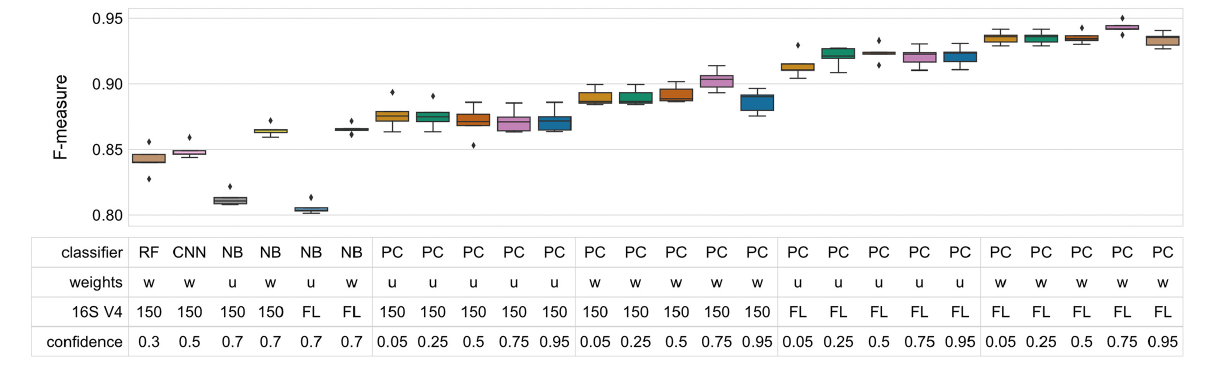
FIGURE 3 | “Perfect” classifiers demonstrate the upper bound of classifier performance for V4 and full 16S rRNA gene sequences. These classifiers only fail when two species share an identical sequence, assuming uniform weights. Taxonomic weighting slightly increases classification accuracy both for V4 and full-length sequences. Box-and-whisker plots indicate the median and quartile distributions of F-measures for each classifier, across 5-fold of CV. The top-performing NB, RF, and CNN classifiers (trained and tested on V4 sequences) are compared to the “perfect” classifiers to demonstrate that the upper bound of performance is already being approached. All differences were statistically significant when comparing the top-performing classifiers to “perfect” classifiers evaluated with similar parameters (Wilcoxon rank sum test, p < 0.05). (Weights: w, weighted; u, uniform; 16S V4, 150–150 nt fragment of 16S rRNA V4 region; FL, all of the V4